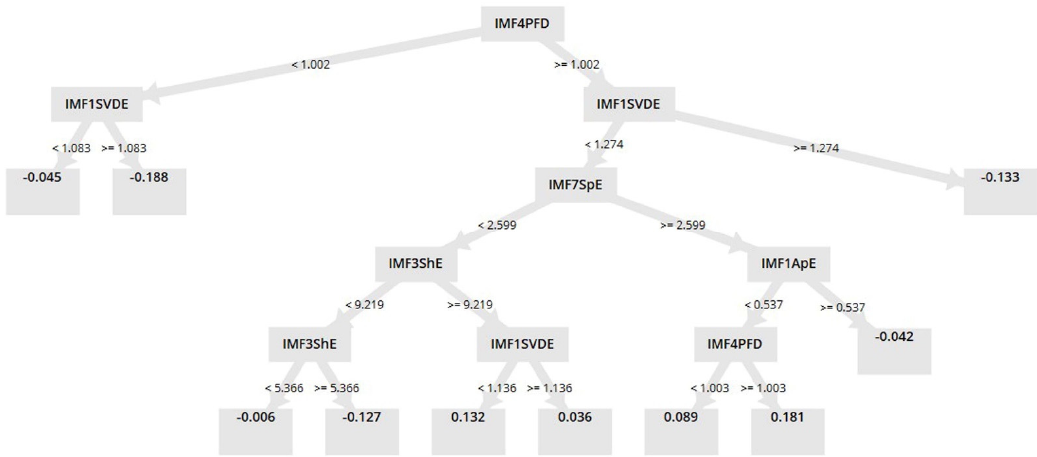
Figure 2. A typical classification tree generated by the GBT Model .